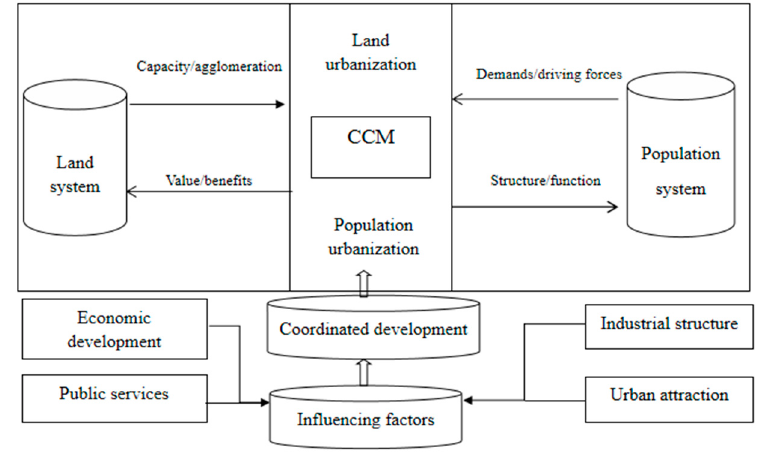
Figure 2. The coordination framework of land and population for urbanization.